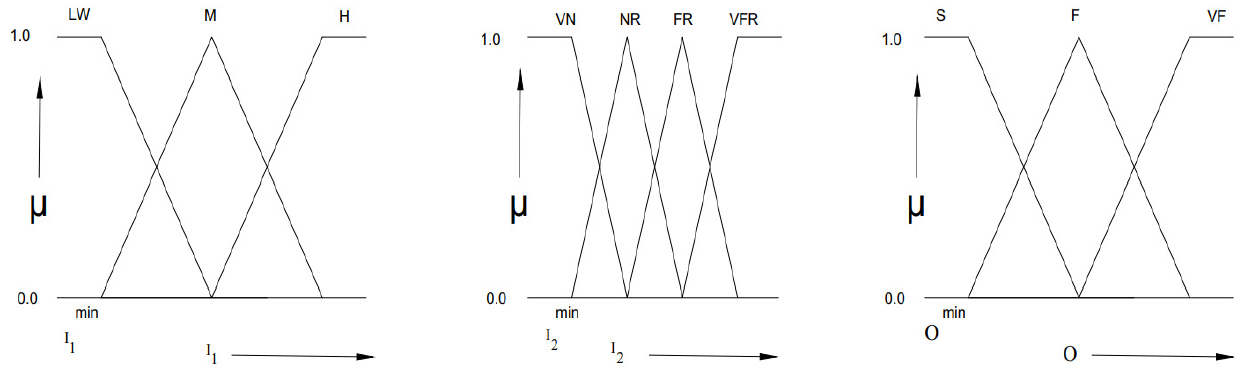
Figure 13. Membership function distributions of input and output variables.